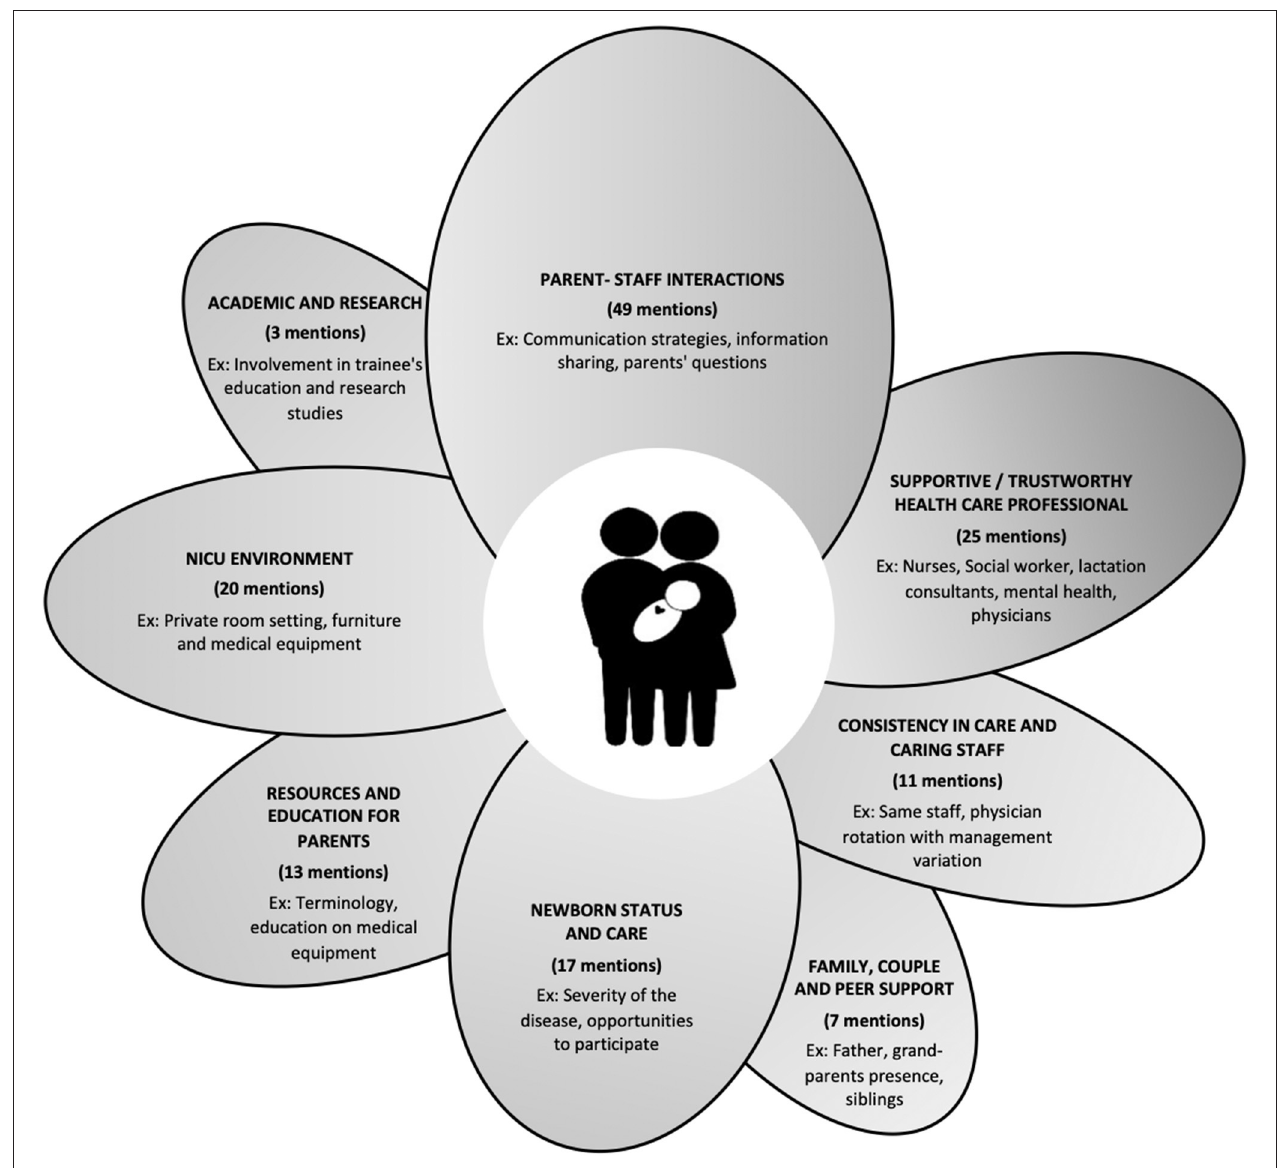
FIGURE 1 | Themes of parental involvement in newborn